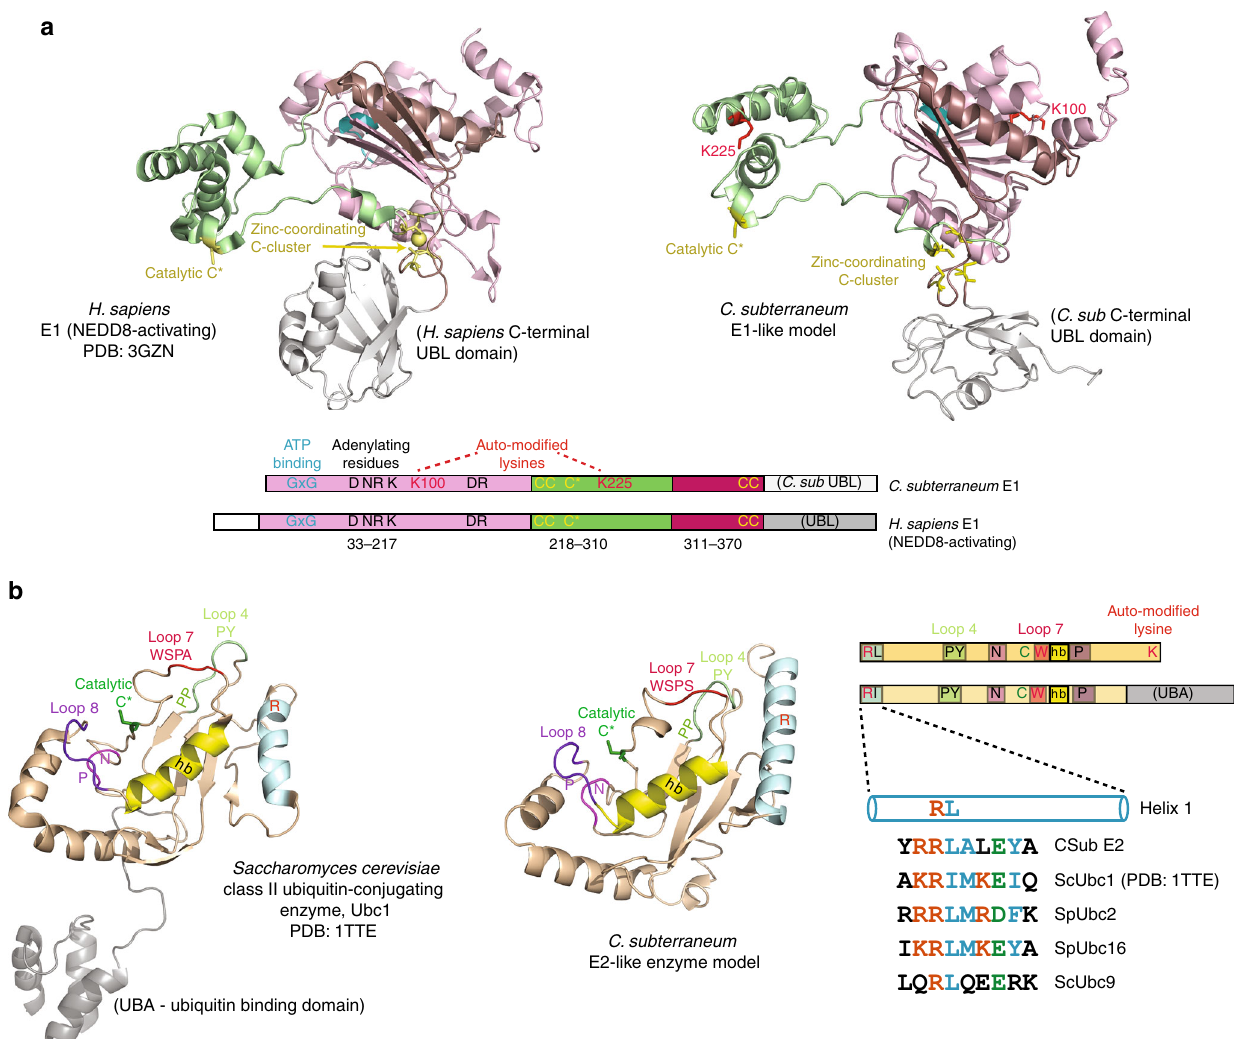
Fig. 3 Structural features and key residues conserved between the C. subterraneum and eukaryotic E1-like and E2-like homologues. a top left; Crystal structure of the H. sapiens NEDD8 activating E1-enzyme (PDB: 3GZN) predicted as a structural homologue of the C. subterraneum E1-like enzyme by PHYRE2; top right I-TASSER model of the C. subterraneum E1-like enzyme. Active and inactive Rossman fold domains are coloured dark and light salmon, respectively; the active cysteine-containing domain is coloured green (key cysteines are shown as gold sticks); the ubiquitin-like (UBL) domains are coloured grey. A coordinated zinc-ion is represented by a gold sphere. The two speci fi c auto-ubiquitylated lysine residues in the C. subterraneum structure are shown as red sticks. The glycine rich ATP-binding loop is coloured blue. bottom, schematic representation of the Homo sapiens and C. subterraneum E1- like enzymes with colours as described in a . Yellow ‘ C ’ s represent the zinc-binding and catalytic cysteine residues. Blue ‘ GxG ’ lettering denotes the glycine- rich ATP-binding loop. Conserved ‘ D ’ , ‘ NR ’ , ‘ K ’ and ‘ DR ’ residues are critical for ubiquitin adenylation in eukaryotic E1-enzymes 38 are indicated (see Supplementary Notes 2 and 3 for further details). b left; crystal structure of the S. cerevisiae Ubc1 E2-enzyme (PDB: 1TTE), a PHYRE2 predicted homologue of the C. subterraneum E1-like enzyme. Middle: I-TASSER model of the C. subterraneum E2-like enzyme. The N-terminal E1-interacting helix is coloured light blue ( ‘ R ’ indicates an invariant arginine), the hydrophobic cross-over helix (labelled ‘ hb ’ ) is coloured yellow; the catalytic cysteine shown as green sticks (labelled ‘ C ’ ). The HPN loop is labelled ‘ N ’ and coloured magenta. Loop 4 is coloured light green and labelled ‘ PS ’ , while loop 7 is coloured red and labelled ‘ WSPA/S ’ . Loop 8 is coloured purple (labelled ‘ P ’ ) and the S. cerevisiae UBA domain is shaded grey. Structural fi gures generated using PyMOL. right; schematic representation of the S. cerevisiae and C. subterraneum E1-like enzymes with the same colours and labels. The consensus sequence of the conserved E1 (or E3) interacting motifs for the C. subterraneum E2-like enzyme, and yeast E2 homologues ( S. cerevisiae Ubc1 and Ubc9 and S. pombe Ubc2 and Ubc16) are illustrated. Structural fi gures were prepared using